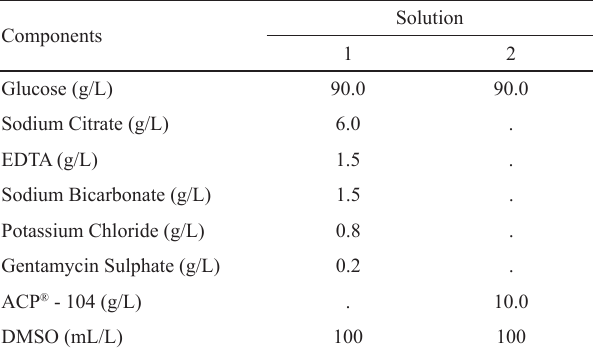
Table 2. Composition of extenders used in experiment with Colossoma macropomun